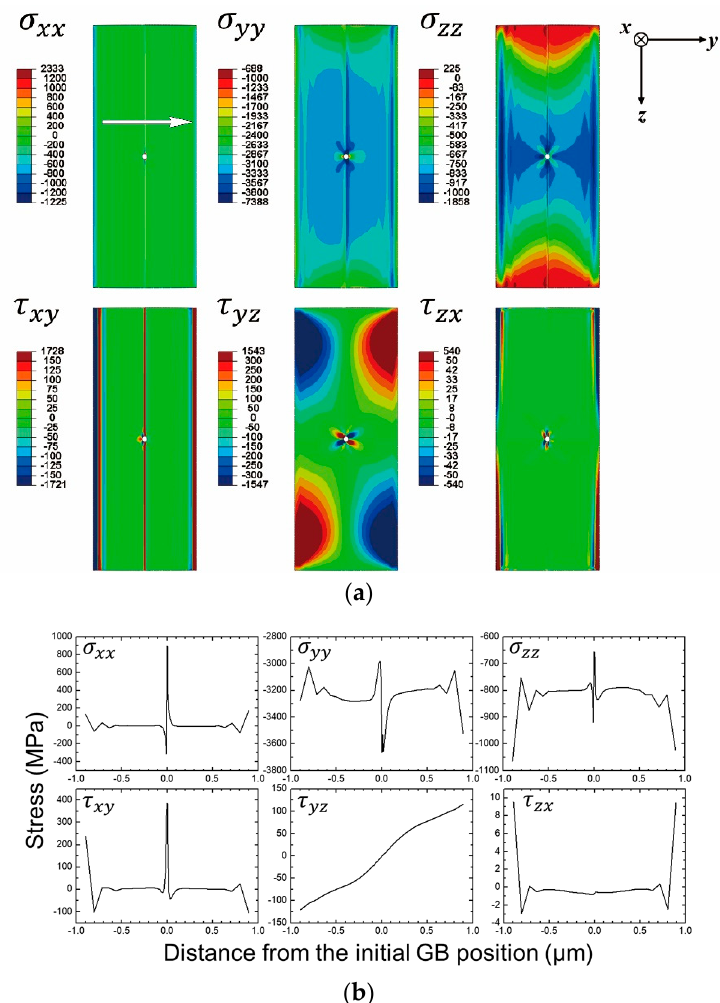
Figure 2. ( a ) Stress maps for the normal and shear components and ( b ) corresponding plots. The arrow in the map of σ xx indicates the data export points for the plots, which also applies to the plots in Figure 3. Reprinted from Ref. 4 with permission; Copyright Springer 2019.